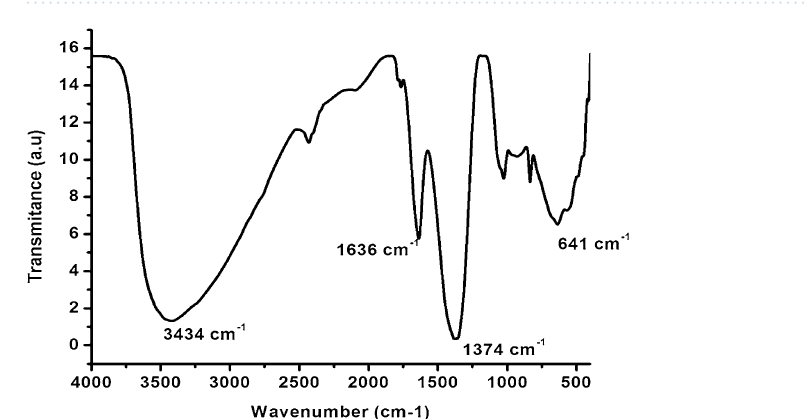
Figure 3. ( a ) N 2 adsorption–desorption isotherm, ( b , c ) specific surface area pore volume and ( d ) pore size of the Fe